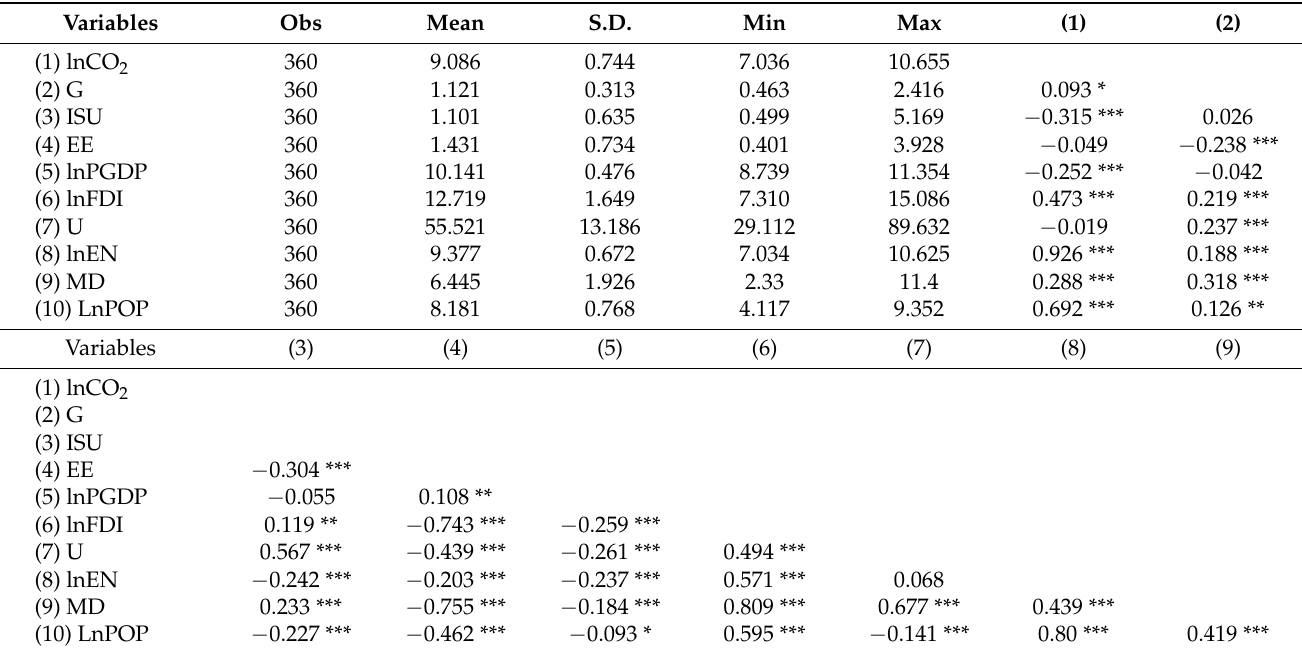
Table 3. Descriptive statistics and pairwise zero-order